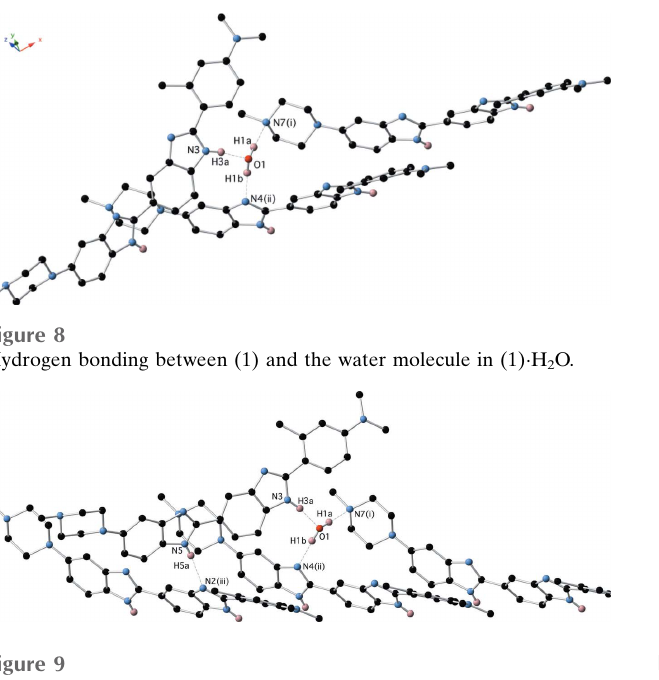
Figure 9 Direct N—H (cid:2)(cid:2)(cid:2) N hydrogen bonds between benzimidazole moieties of (1) (cid:2) H 2 O. H (cid:2) (cid:2) (cid:2) N hydrogen bonds between the remaining benzimidazole